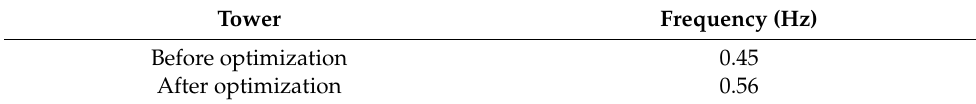
Table 9. Natural frequency comparison of different tower.